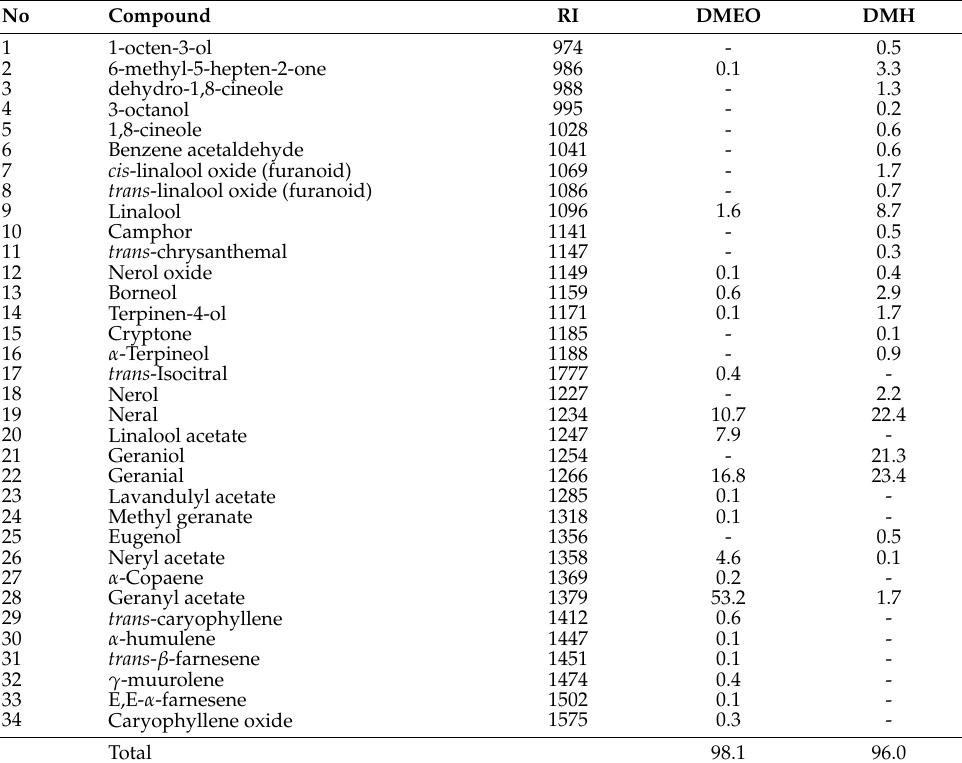
Table 1. Chemical composition of D. moldavica essential oil (DMEO) and hydrolate